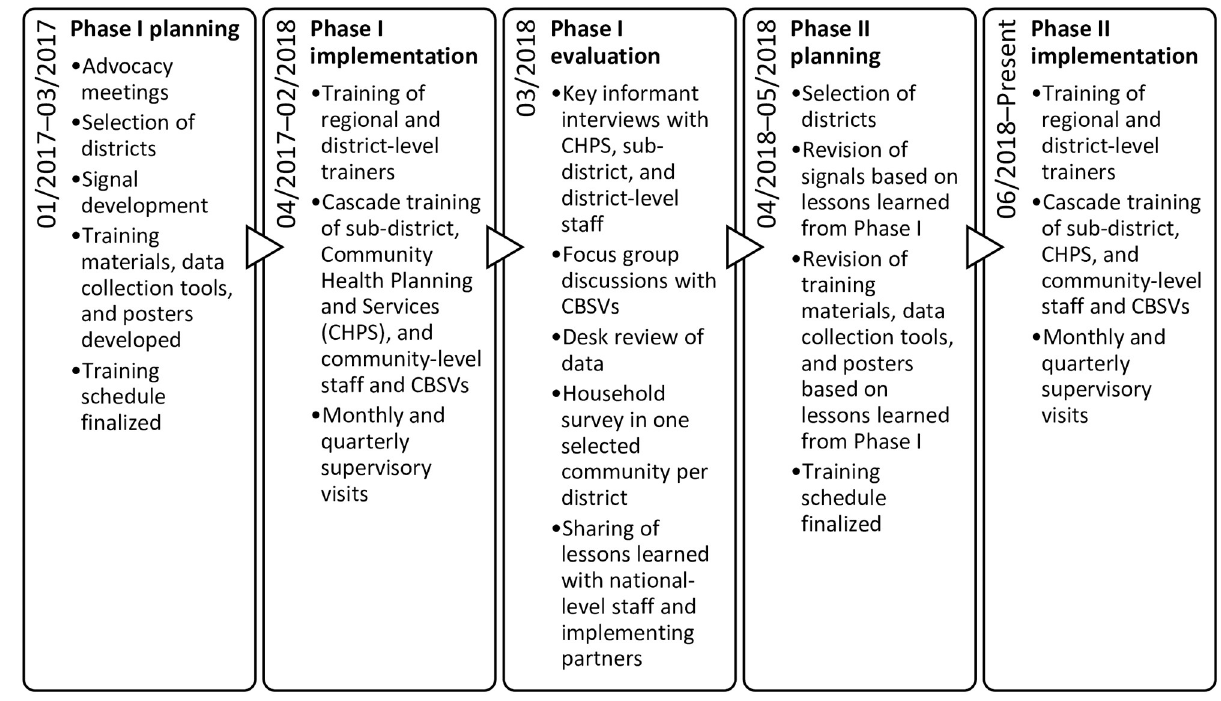
Fig 1. Timeline of Phase I and II modified CBS activities in